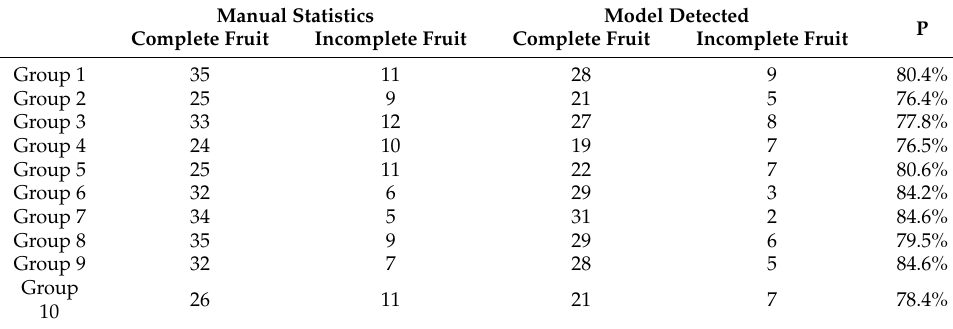
Table 4. Statistical table of prediction results.